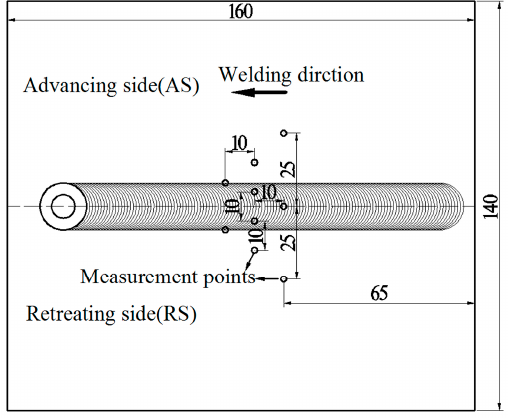
Figure 2. Stress measurement points on the welding specimen (unit: mm).